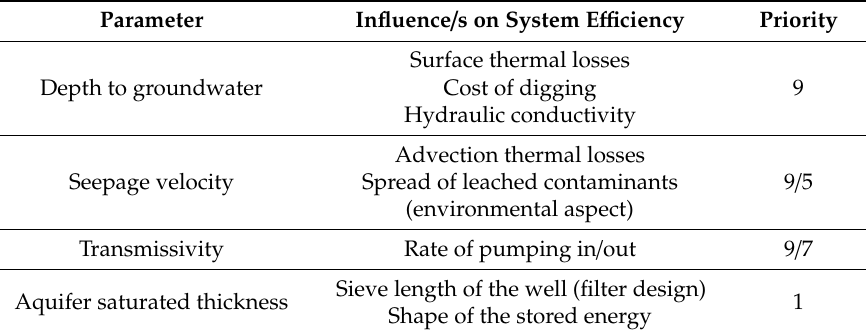
Table 3. Priority of the in-site